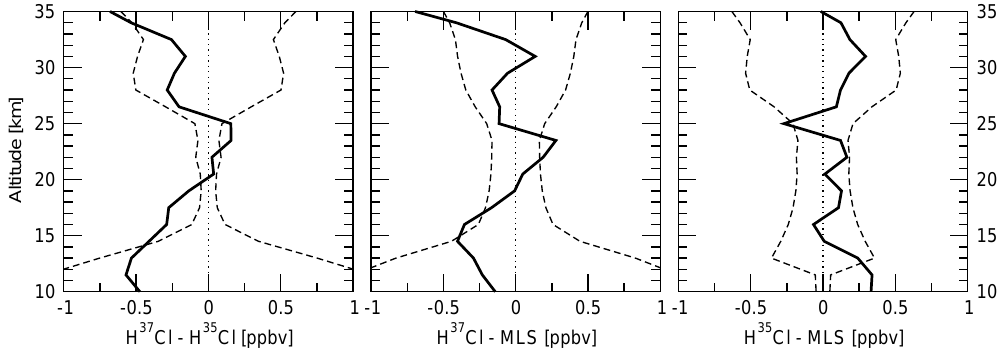
Fig. 5. The differences between the two TELIS HCl profiles, the TELIS H 37 Cl and MLS profiles, and the TELIS H 35 Cl and MLS profiles are plotted in respectively the left, central, and right panel. The dashed lines indicate the RSS of the precision and all systematic errors of both particular profiles.